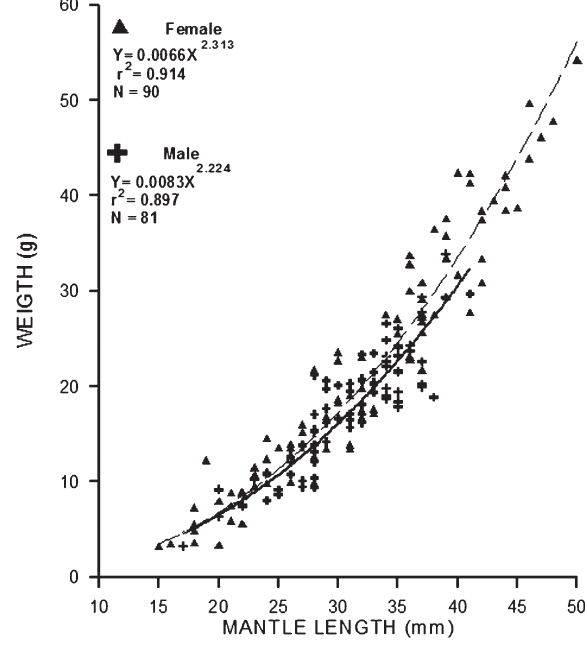
Fig . 3. – Comparison of ML and BW relationship of male and fe- male N.